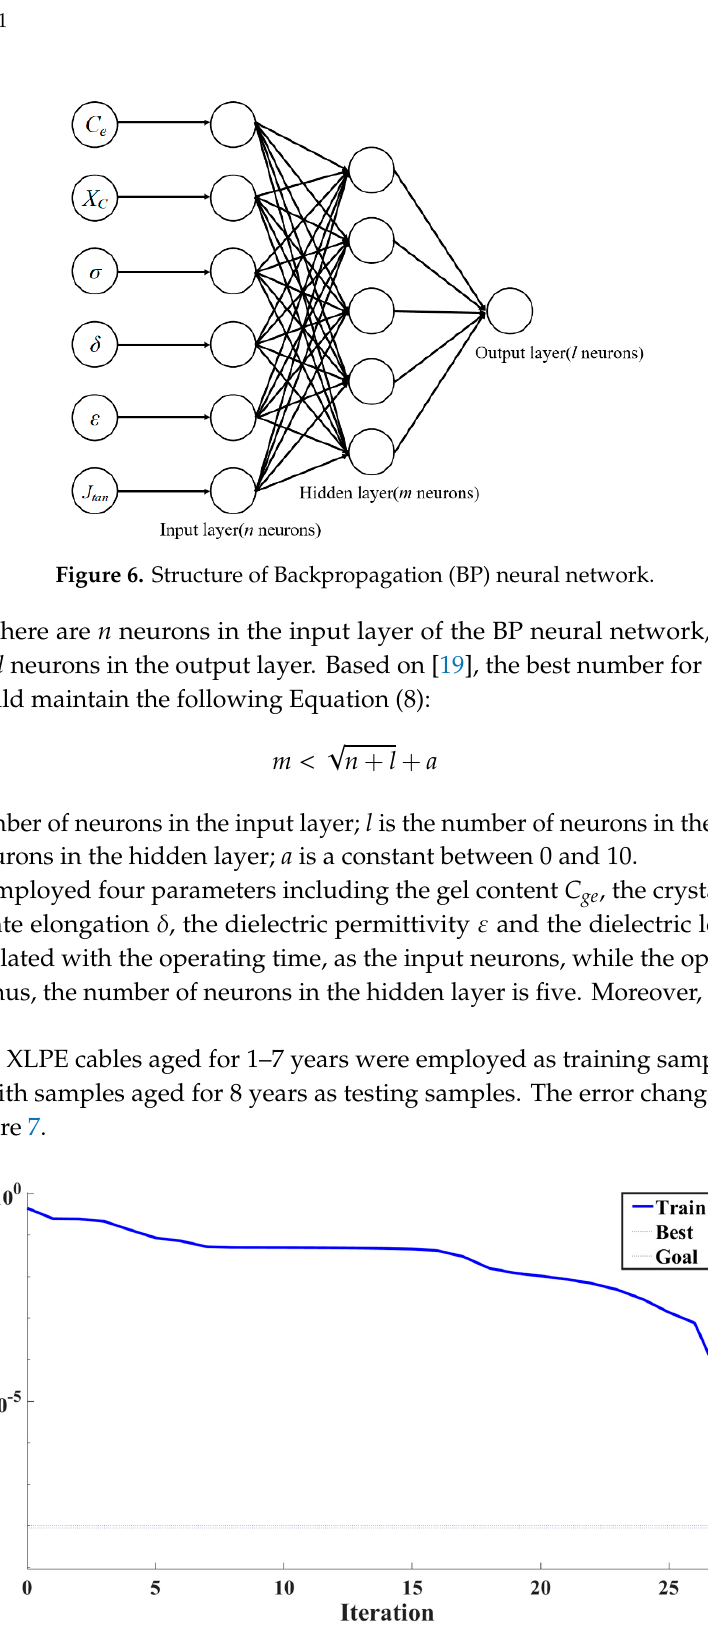
Figure 7. Drop in deviation by training.